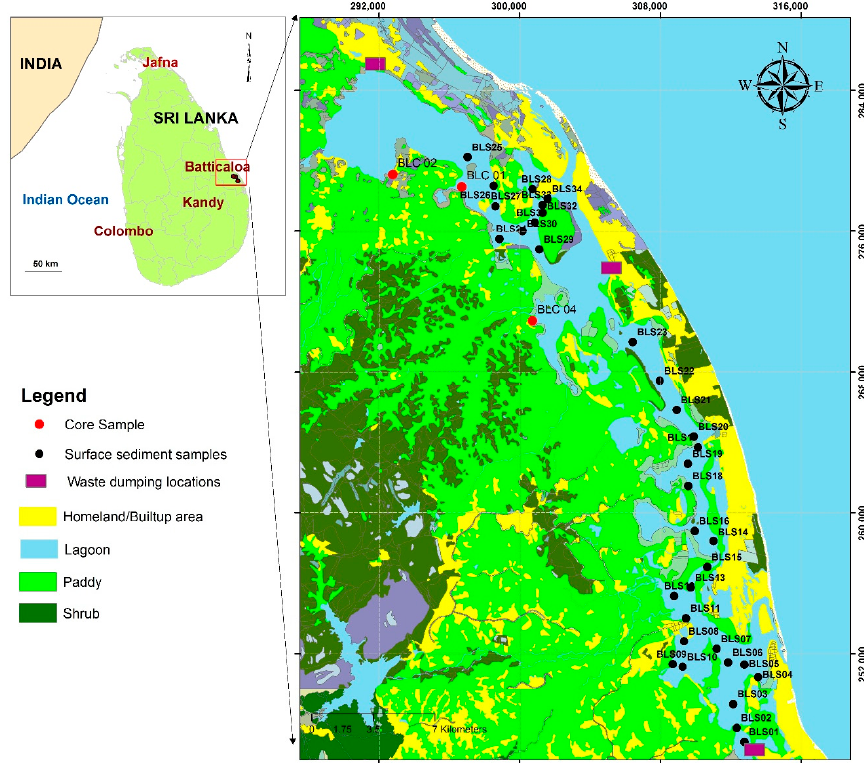
Figure 1. Sediment cores and surface sediment sampling locations of Batticaloa lagoon, Sri Lanka.